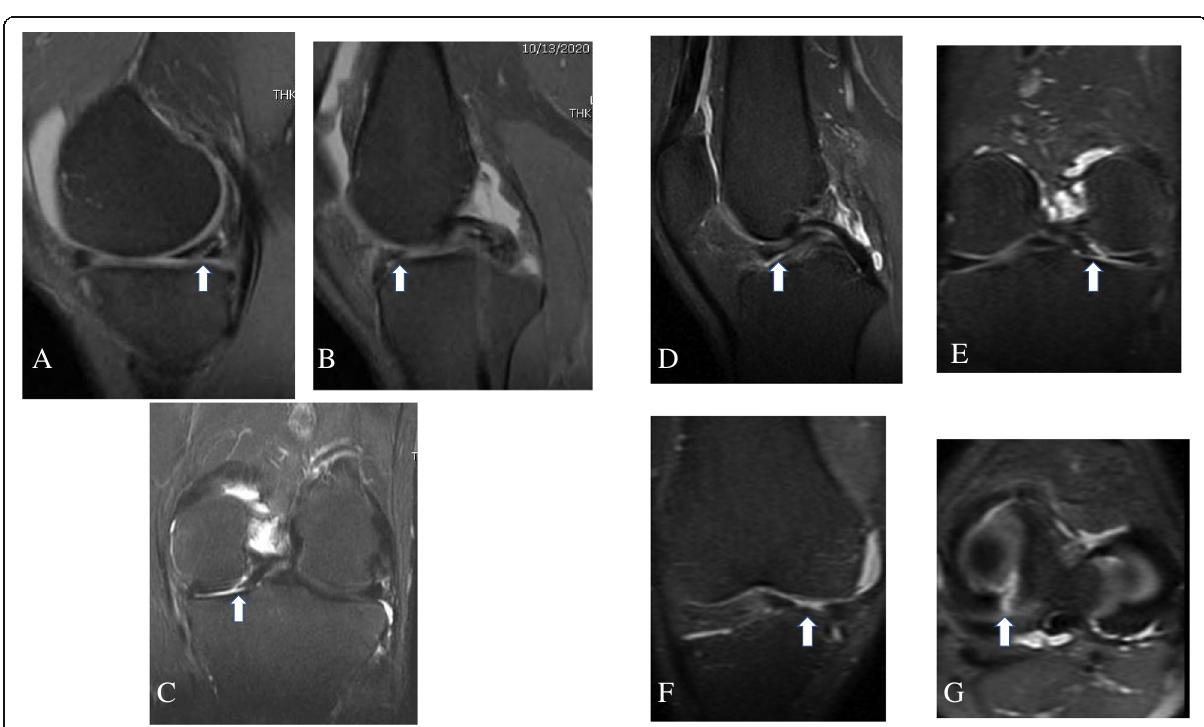
Fig. 4 A 35-year-old male patient presented by acute left knee pain after trauma. a , b Sagittal standard 2D PD WI and c coronal standard 2D PD WI, showing bucket handle tear at the PHMM, arrowed at a and c , with flipped meniscal fragment anteriorly posterior to the anterior horn, arrowed at b . d – g 3D MPR VISTA images (sagittal, coronal, and axial), showing the flipped triangular meniscal fragment, arrowed at d and f and the bucket handle tear arrowed at e and